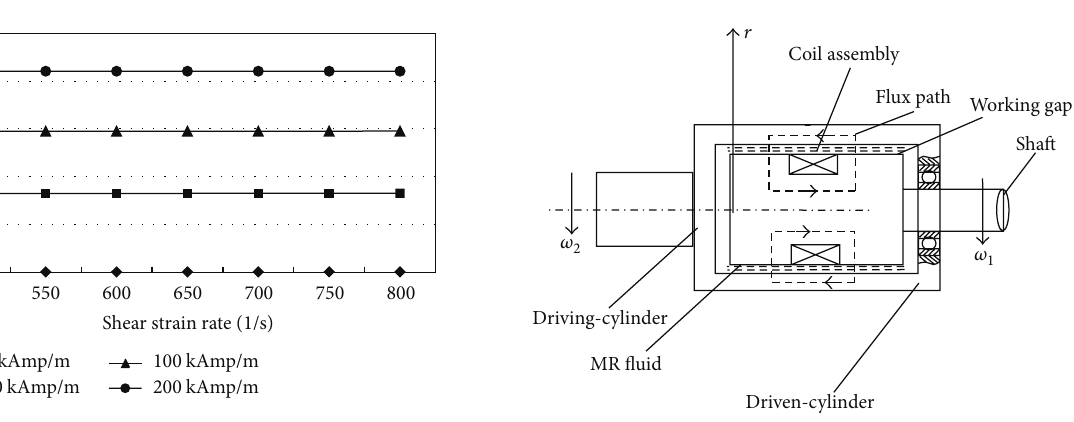
lowers down to be about 1/10 of the original to the maximum.